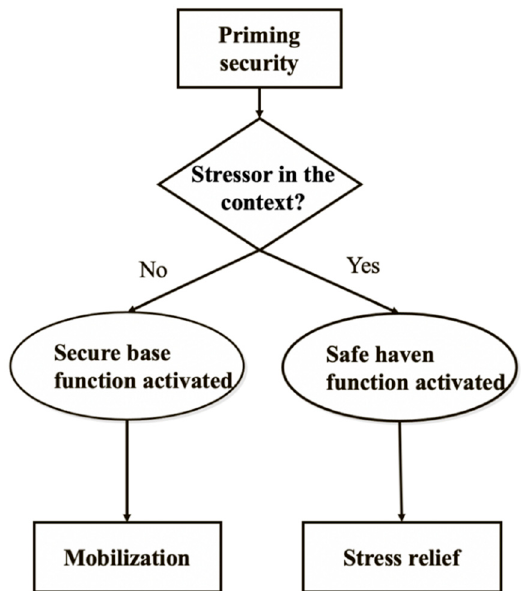
Figure 1. The Dual Function Model of Security Priming.